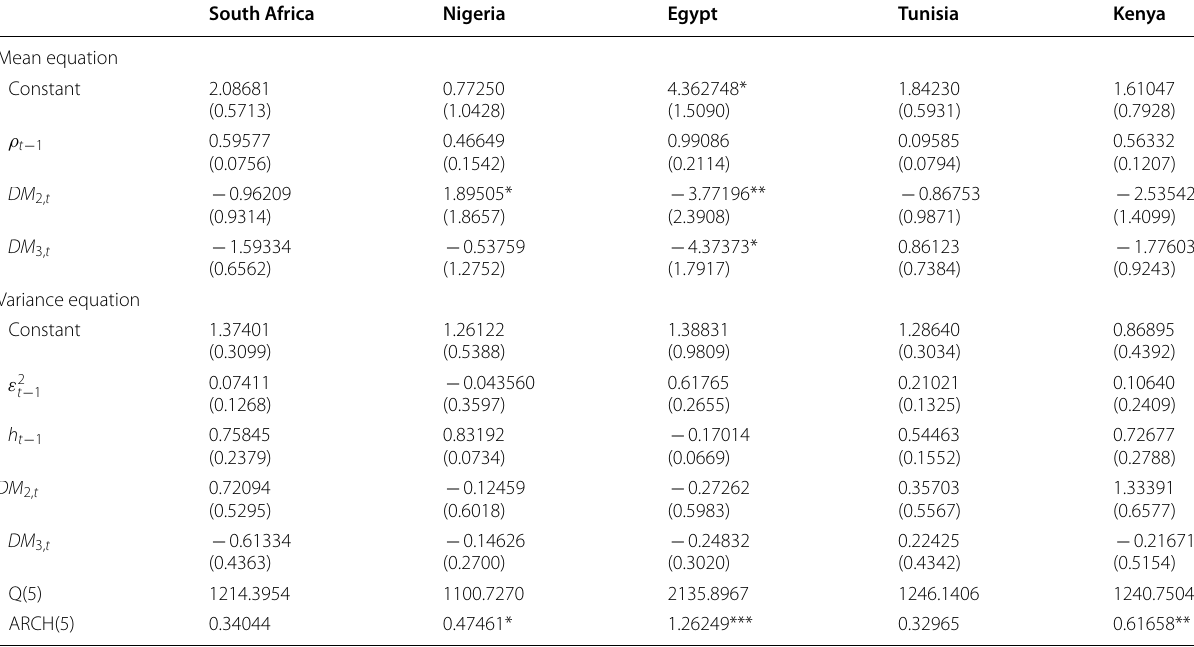
Table 3 Test of changes in dynamic correlations between market stock returns during different phases of the crisis.